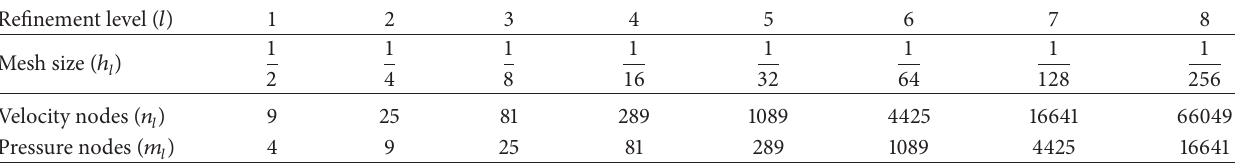
Table 1: Refinement levels and number of nodes ( 𝑛 𝑙 : number of velocity unknowns ( × 2) and 𝑚 𝑙 : number of pressure unknowns). Refinement level ( 𝑙 )